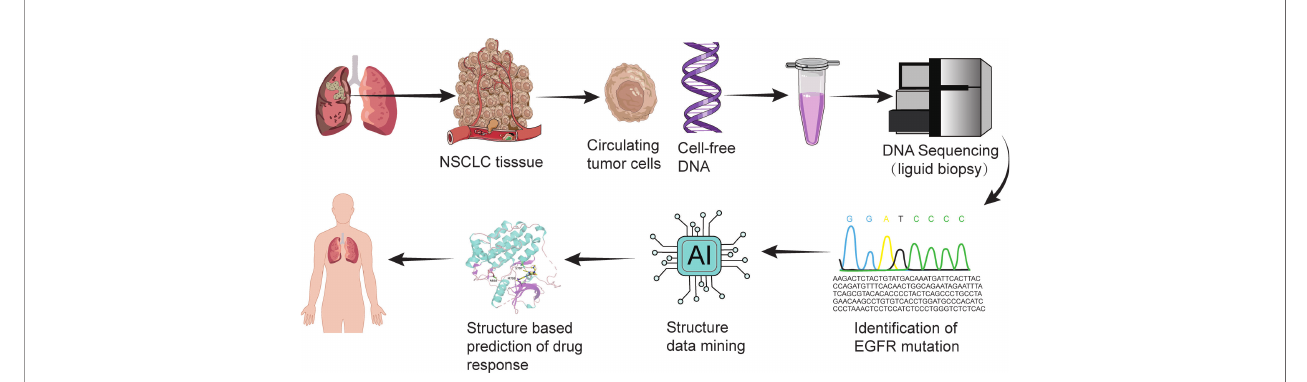
FIGURE 2 | Liquid biopsy and structure-based drug response prediction promote osimertinib-centered precision medicine against uncommon EGFR mutation- positive